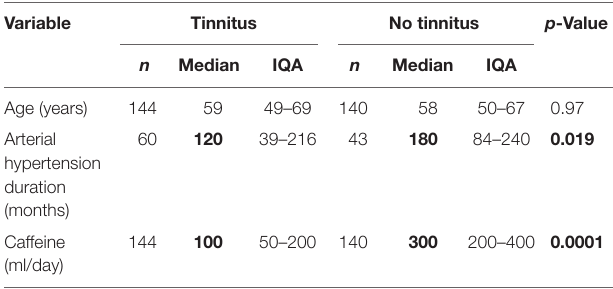
Significant values in bold. IQA, Interquartilic Amplitude: Q1–Q3. Table 2 | analysis of categorical variables (gender, age, race, and presence of arterial hypertension) according to the groups. Variable